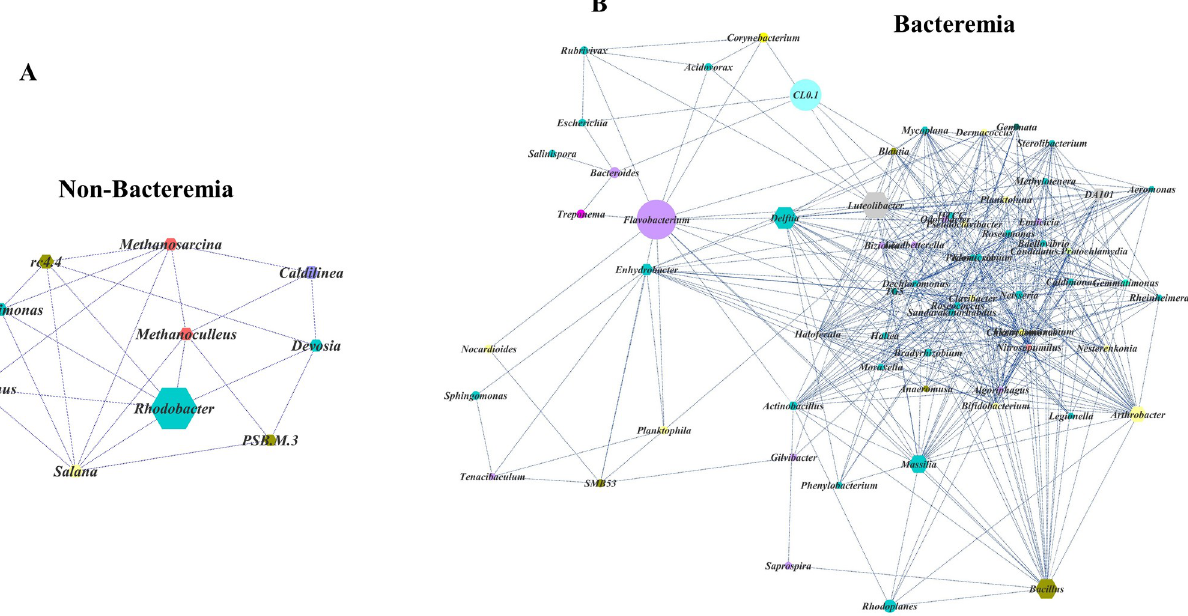
PLOS ONE | https://doi.org/10.1371/journal.pone.0257449 September 16,